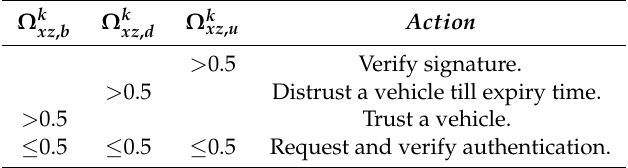
Table 2. Node security level authentication based on trust adjustment rules.